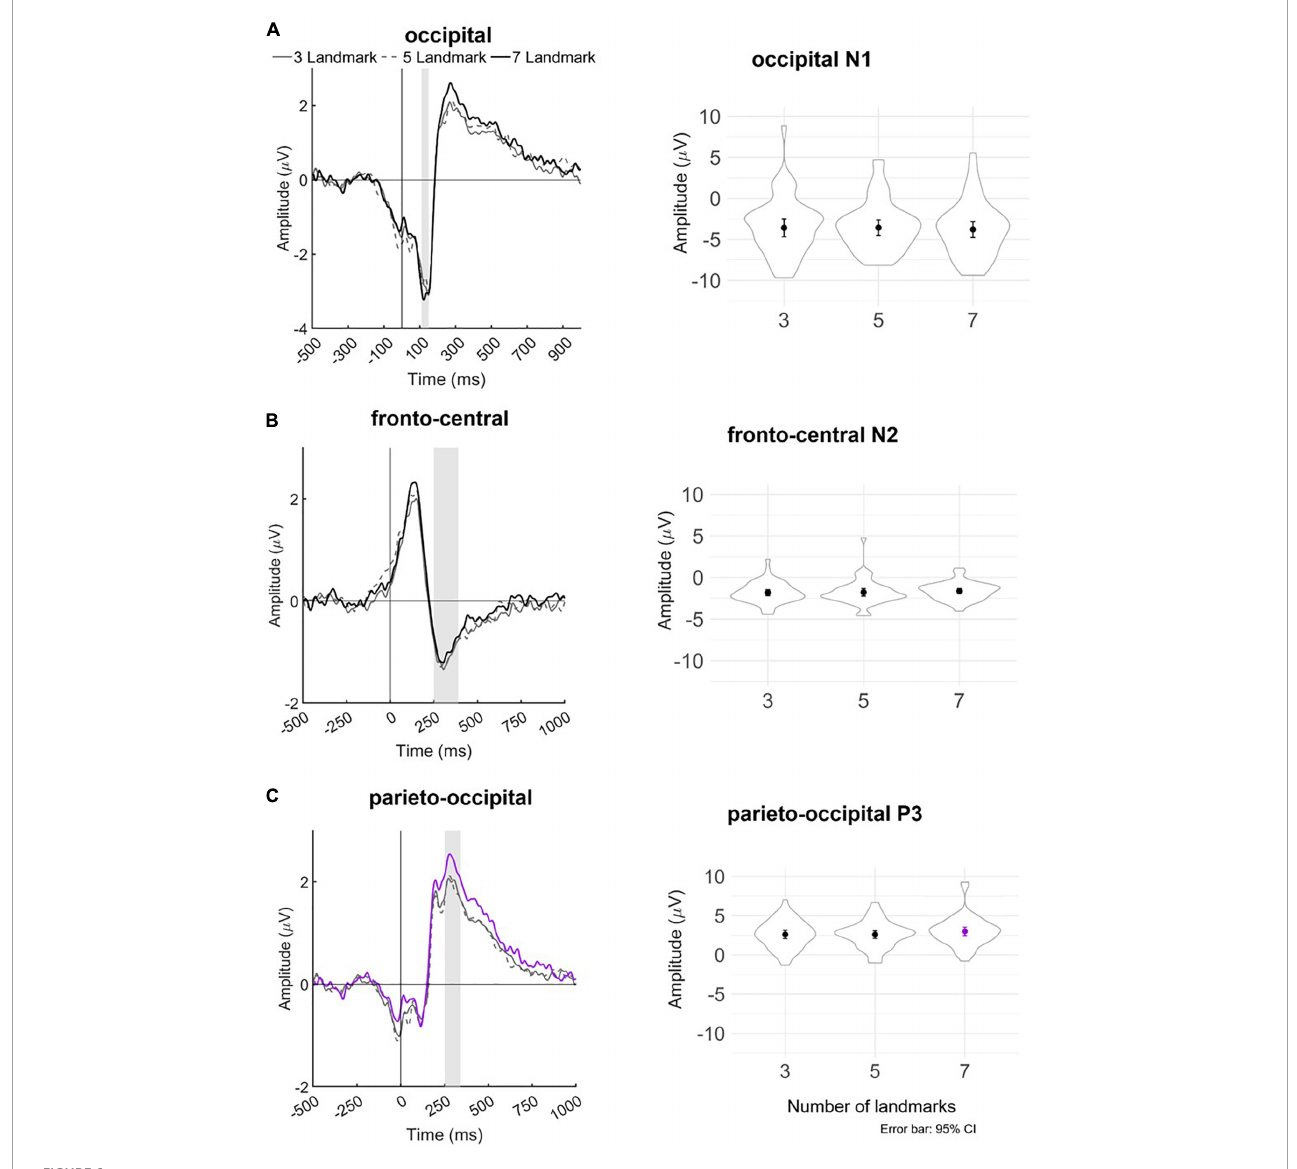
FIGURE6 Left panel: Grand averaged amplitudes of blink-related ERPs for each experimental landmark condition at the (A) occipital lead (Oz), (B) fronto-central leads (Fz and FCz), and (C) parieto-occipital leads (Pz, POz, and Oz). The blink-related ERP signals served as the basis for individual peak detection—vertical bars shaded in gray indicate the time windows in which the respective minima or maxima of the bERPs were identified. Right panel: Violin plots depicting the distribution of detected peak amplitudes together with mean and ± 1.96 standard error (i.e., 95% CI) in each landmark condition for occipital N1, fronto-central N2, and parieto-occipital P3. Line and mean plotted in purple in the bottom panel indicate statistical significance at p <